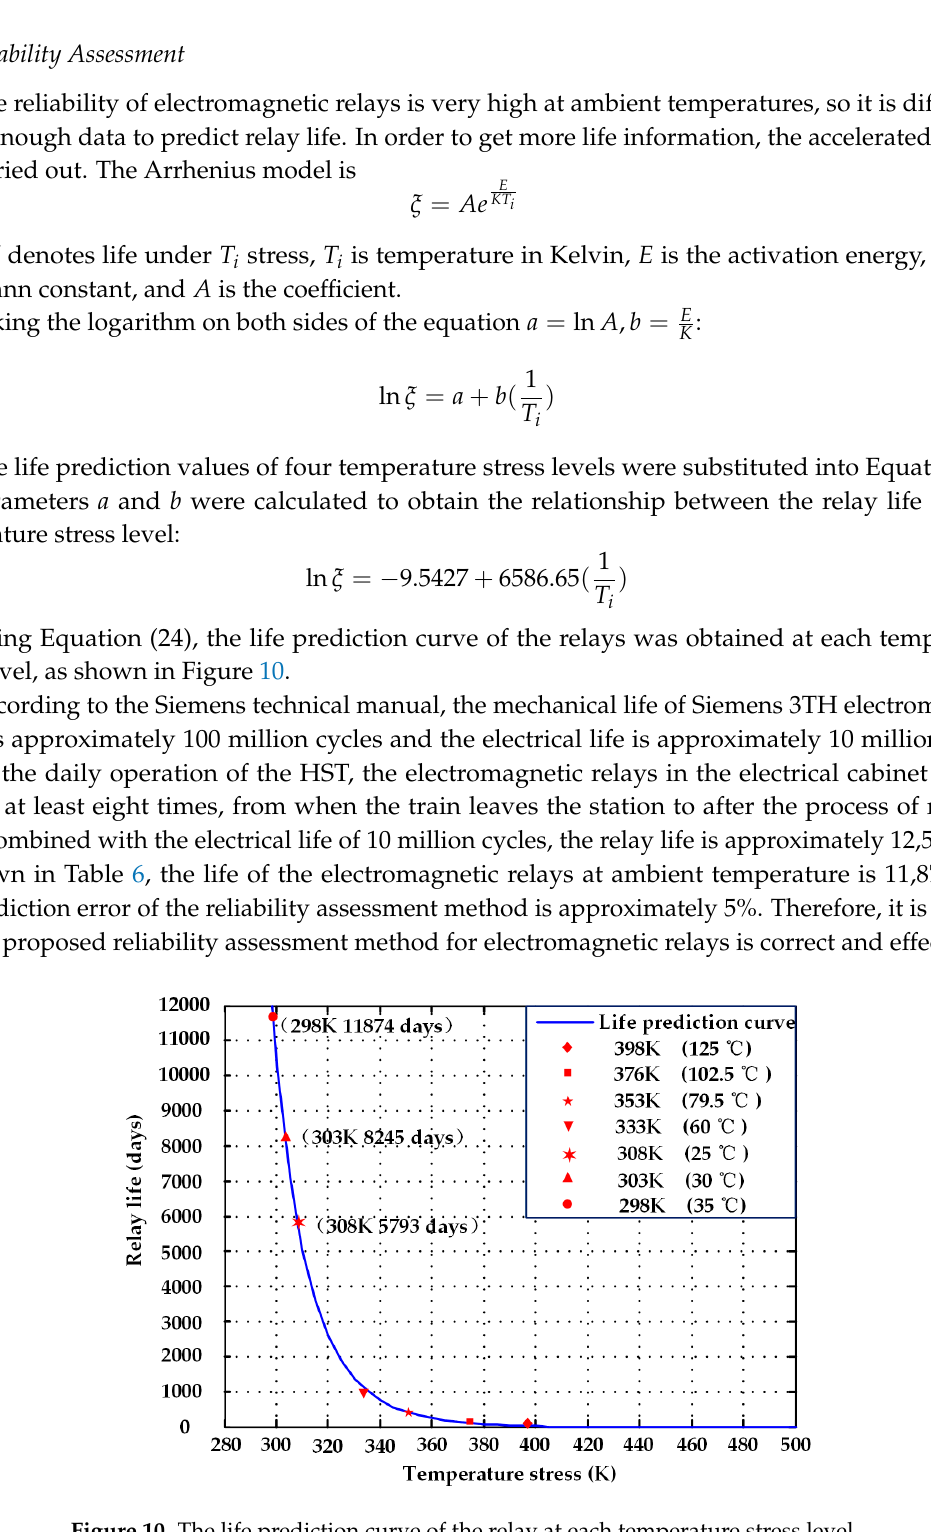
Figure 10. The life prediction curve of the relay at each temperature stress level.